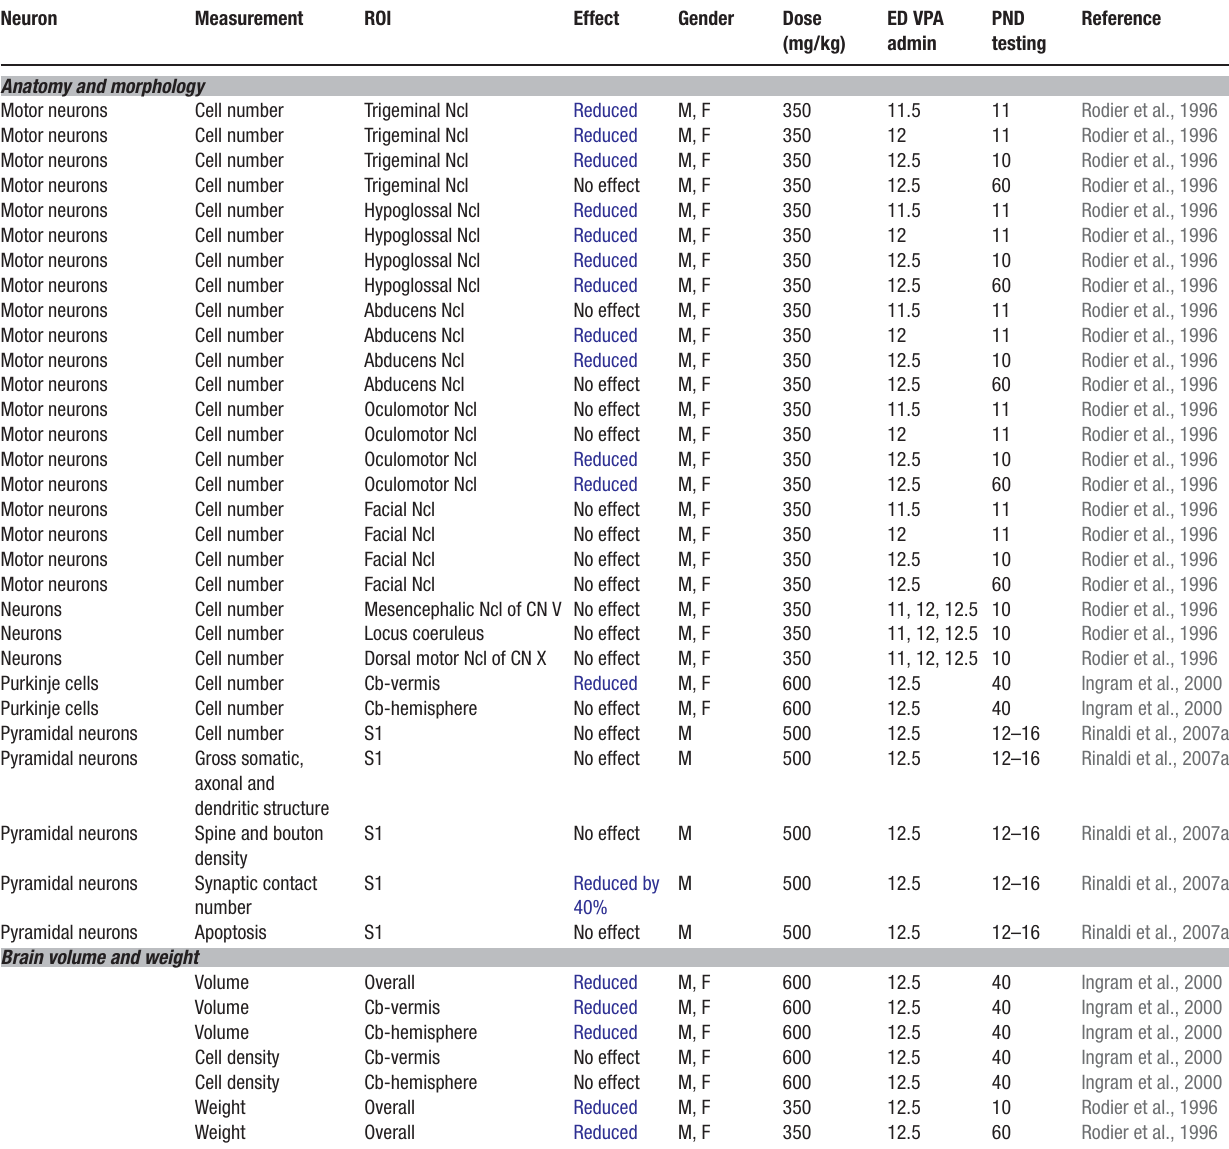
Table 2 . Anatomical and morphological alterations in the VPA rat model of autism. Neuron Anatomy and morphology Motor